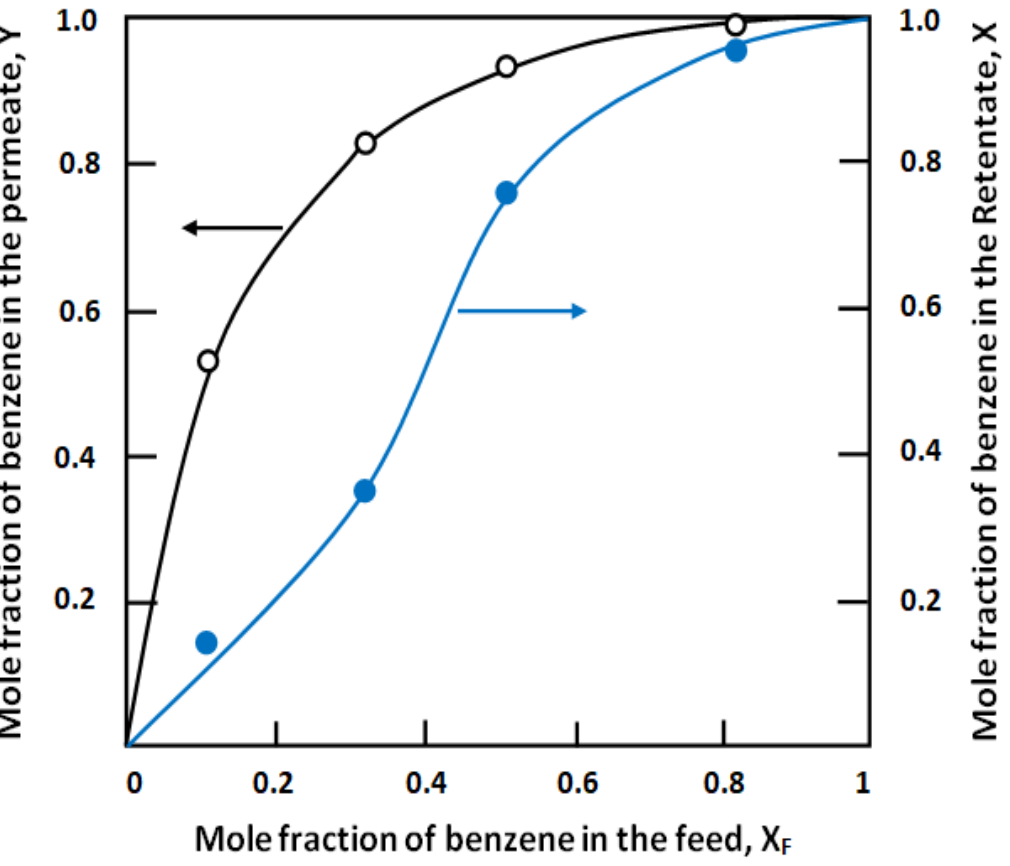
Figure 18. VLPE diagram for pervaporation of benzene / cyclohexane mixtures using E-VOH membrane at 25 °C.